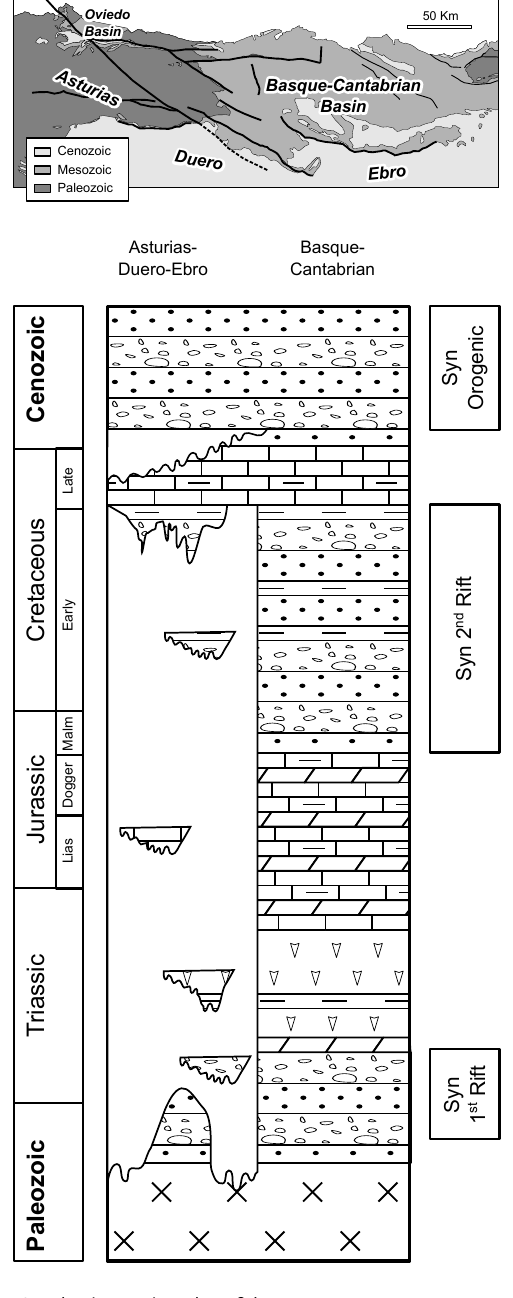
Fig. 4. Synthetic stratigraphy of the area.